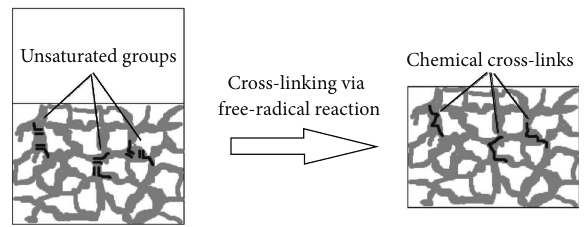
Figure5: Enhancementofmechanicalpropertiesofpolymermatrix via chemical